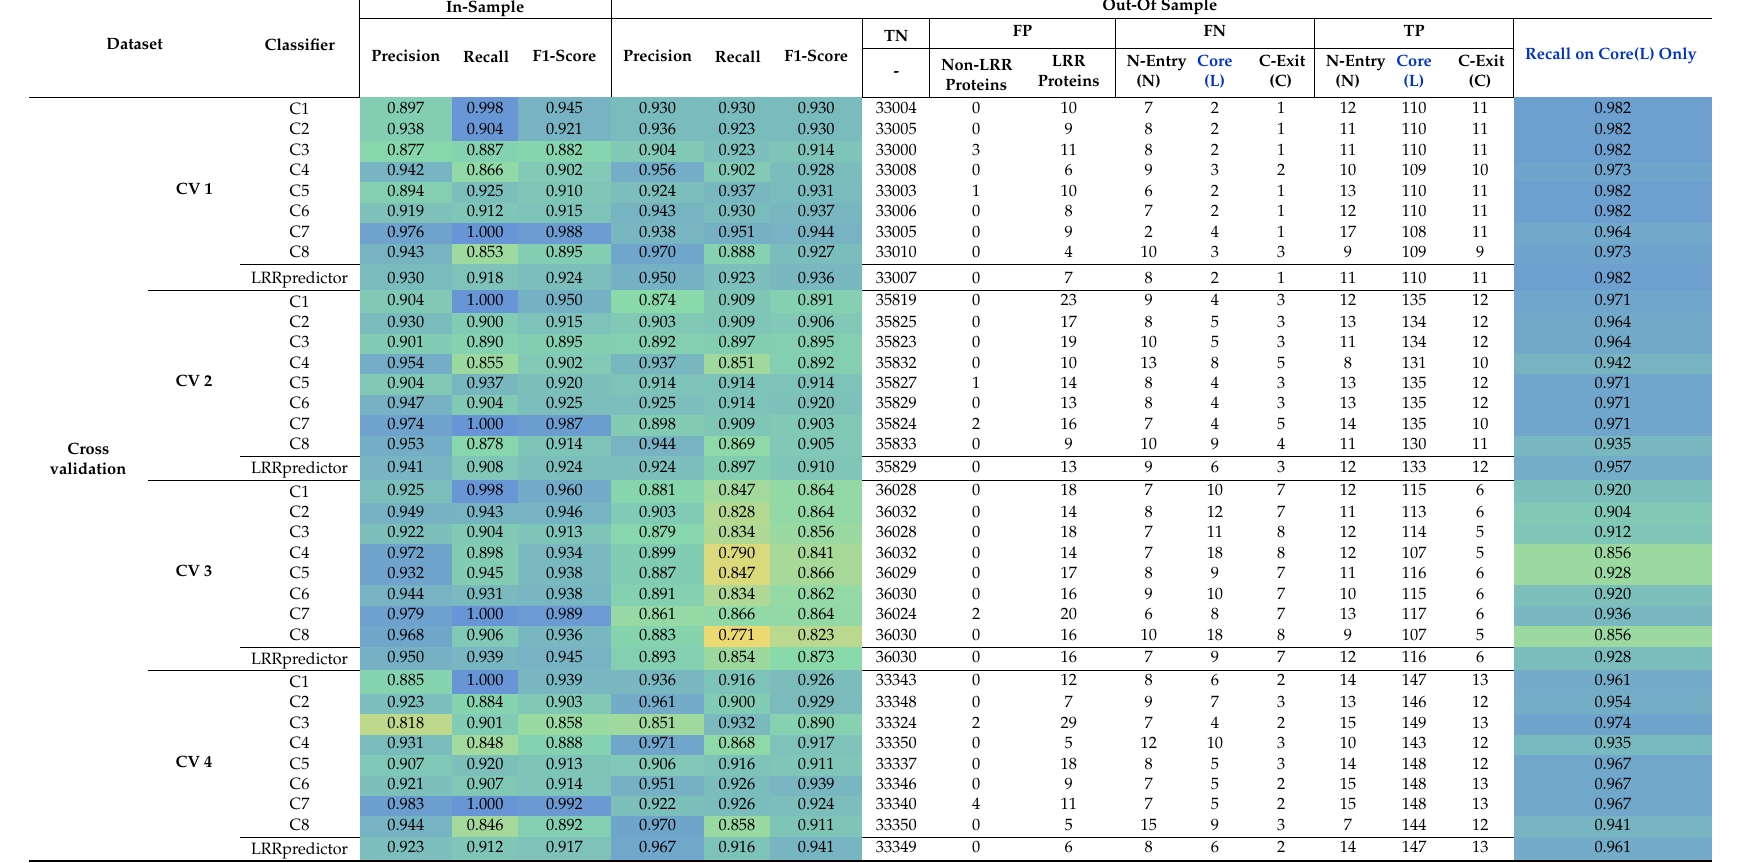
Table A1. Detailed performance analysis on LRRpredictor and its classifiers. Precision recall and F1 scores are shown for in-sample (i.e., training data) and out-of-sample data (i.e., test data that was not used in training), for both cross-validation and test phase. In the cross-validation stage, classifiers were trained on three of the cross-validation (CV) sets and tested on the fourth set in an iterative manner, while in testing stage, classifiers were trained on all four CV sets and evaluated on the test set left aside from the beginning. The counts for true-negatives (TN), false-positives (FP), false-negative (FN), and true-positive (TP) within each set are also shown. As marginal repeats (N-entry and C-exit types) have a lower detection rate, also included is the recall calculated only with respect to ‘core’ repeats (L), indicated with blue font. Performance scores shading is according to a value based colormap from yellow (0.75) to blue